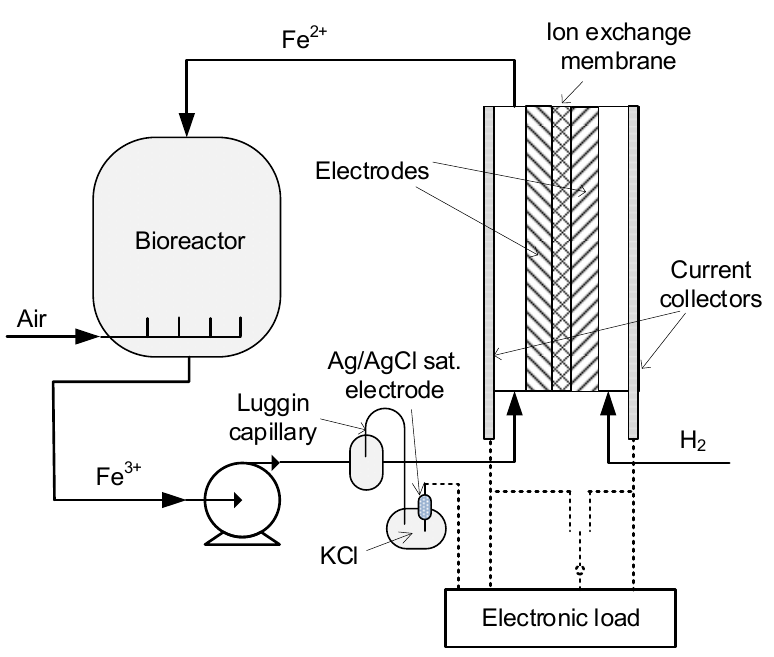
Figure 3. Setup for the testing of membranes in the Fe 3+ /H 2 electrochemical cell with microbiological regeneration of Fe 2+ ions. Adapted from [26].